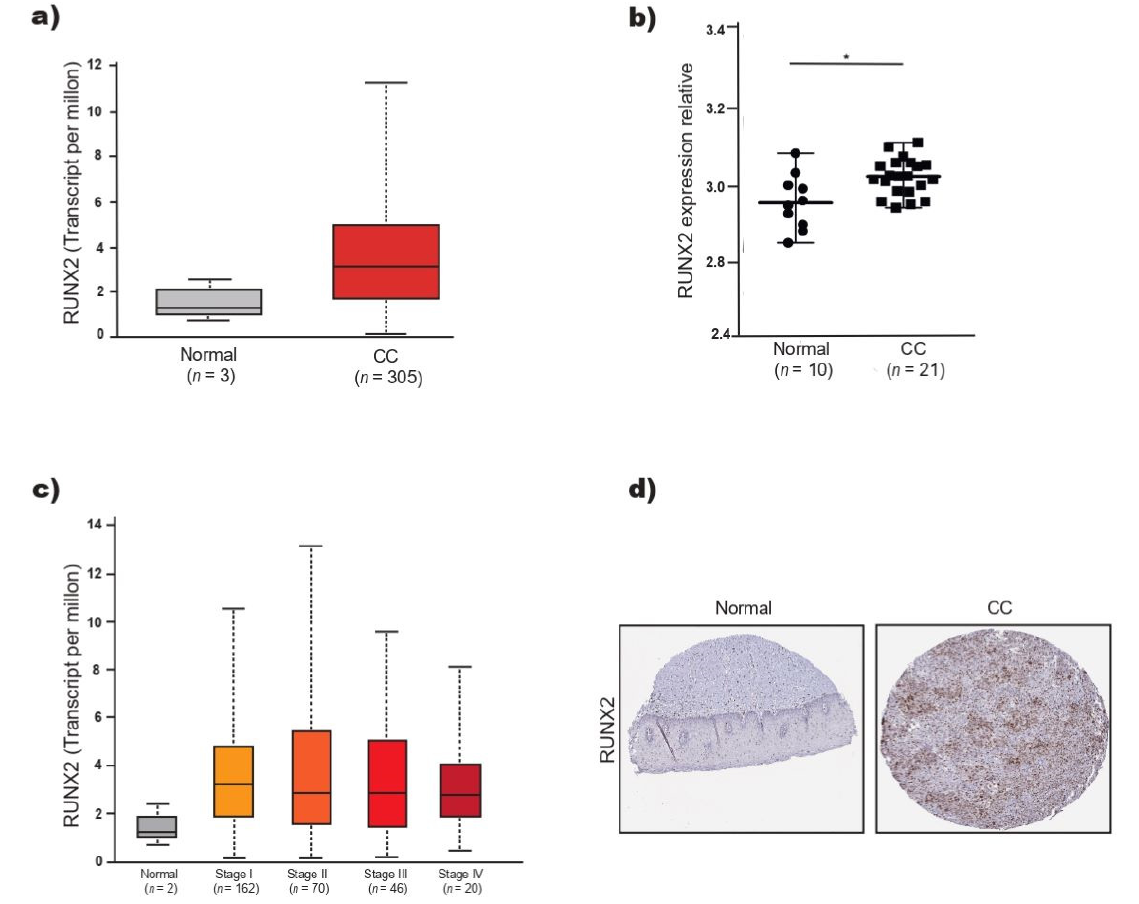
Figure 4. RUNX2 expression in CC. ( a ) RUNX2 expression in CC and normal tissue (TCGA data). ( b ) RUNX 2 expression from the GSE7803 dataset, that includes CC tissues (invasive squamous cell carcinoma, positive for intermediate–risk or high-risk oncogenic HPV) and normal tissues (squamous cervical epithelium). ( c ) RUNX2 expression by stage of cervical tumor. ( d ) RUNX2 expression detected by immunohistochemistry in normal and CC tissues (image available online https://www.proteinatlas.org/ENSG00000124813–RUNX2/pathology/cervical+cancer#img accessed on 25 April 2022). * p < 0.05.